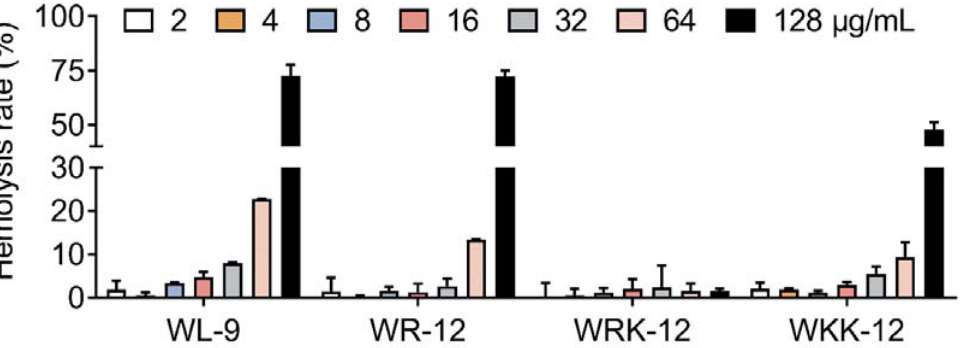
Figure 3. Hemolytic activity of four active peptides against mammalian red blood cells (RBCs). Sterilized PBS (10 mM) and ddH 2 O were used as a negative control and positive control, respectively.